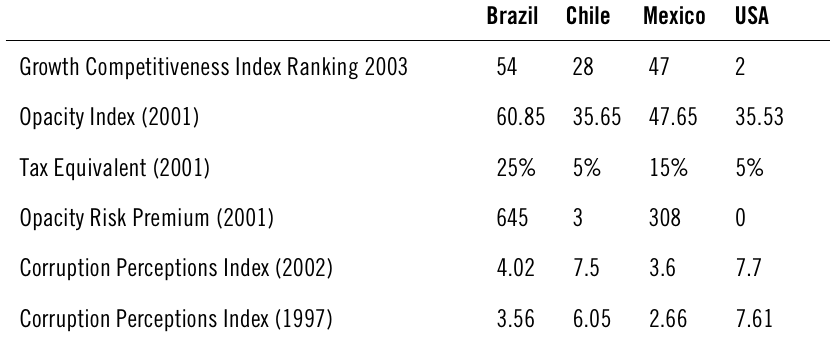
Table 3 – Sample Indices Evaluating Brazil and Select